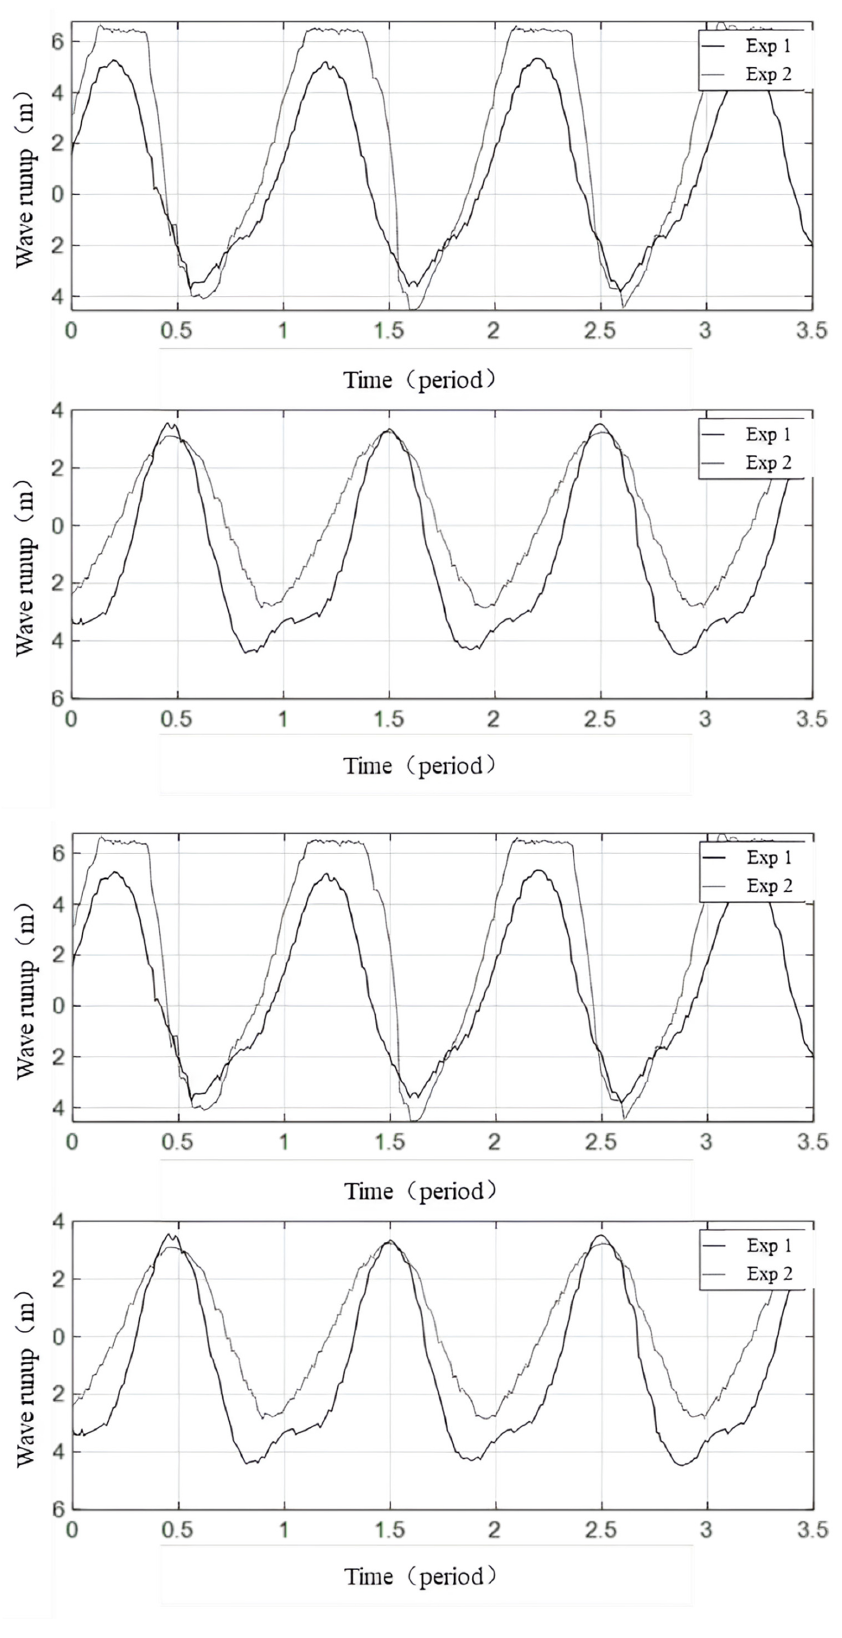
Figure 11. Wave run-up at Dazuo Seawall for the highest wave and highest tide of typhoons, Usagi ( upper ) and Dujuan ( lower ) .